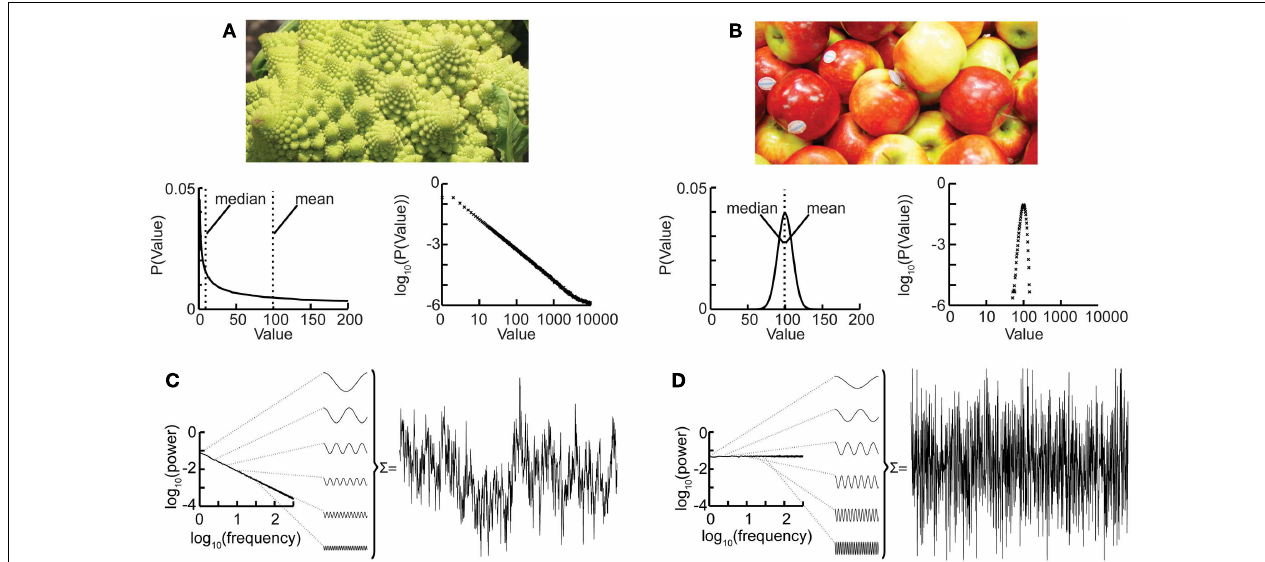
different scales. (B) As the size of apples shows smaller variation they are well described by taking an average value such as the mean or median. ( bottom left ) Hypothetical distribution showing the likelihood of apples having a certain size. Both the mean and median are good statistics to convey the size of the apples. ( bottom right ) Plotting the normal distribution on double-logarithmic coordinates has little effect on the appearance of the distribution, which still shows a characteristic scale. (C) Time-signals can also be viewed as self-affine as they can be transformed into a set of sine-waves of different frequencies. In a 1/ f signal the lower frequency objects have larger amplitude than the higher frequency objects which we can compare with there being fewer large cauliflowers than there are small cauliflowers. (D) A white-noise signal is also self-affine, but now the lower frequency objects have the same amplitude as the higher frequency objects meaning that only the high-frequency fluctuations are visible in the